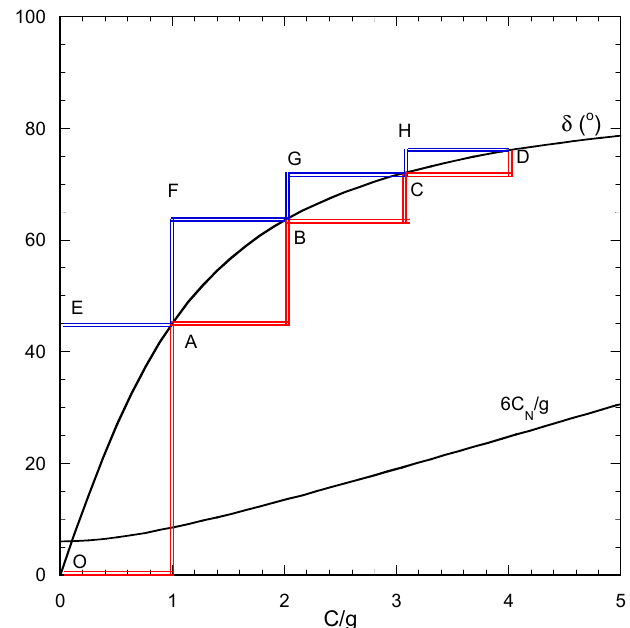
Figure 9. The required centrifugal acceleration C- tilting angle δ trajectory to ensure zero tangential acceleration in practice and the corresponding normal acceleration component C N . Alternative stepwise trajectories (with names A-H, O given at key positions) are shown.